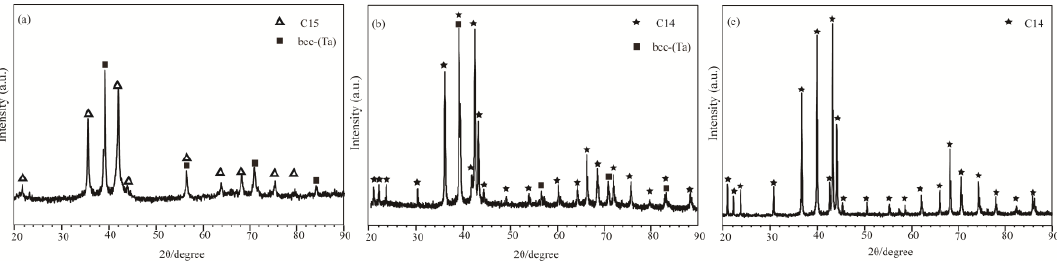
Figure 3. The XRD patterns of typical alloys in the Ni-V-Ta system annealed at 1000 °C for 55 days.